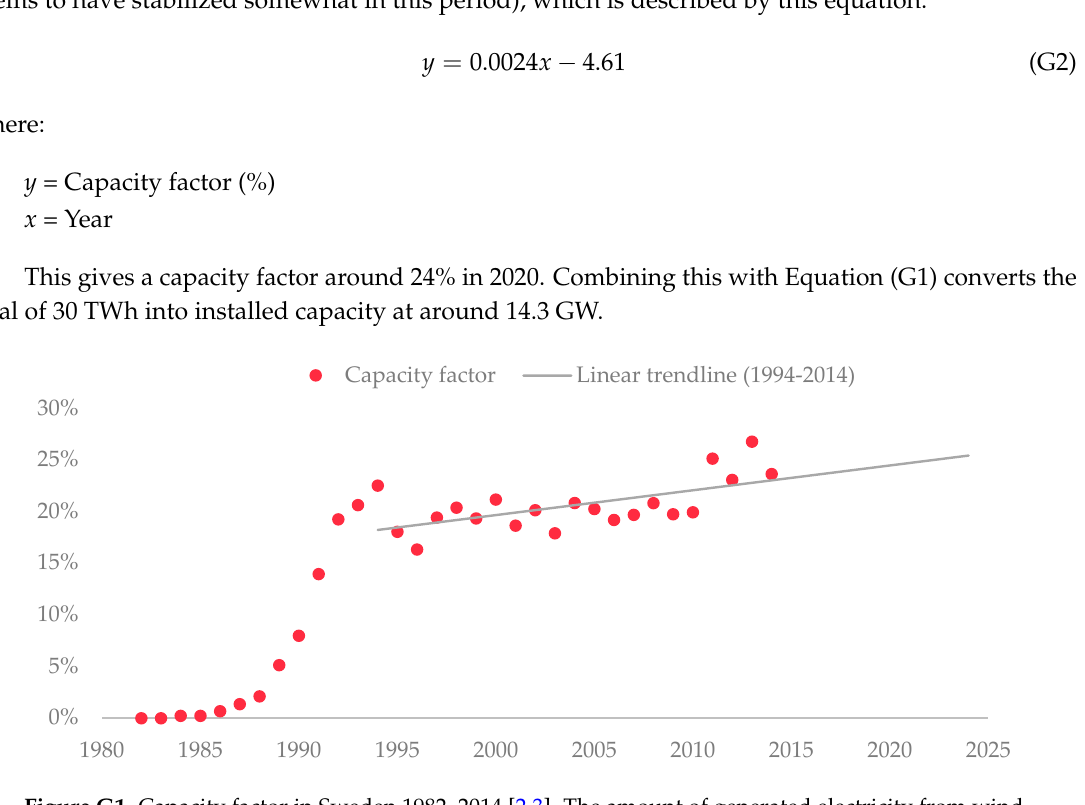
Figure G1. Capacity factor in Sweden 1982–2014 [2,3]. The amount of generated electricity from wind power per year divided with the maximum possible output if all turbines run at full power for the entire year. The trend line is based on data in 1994–2014.